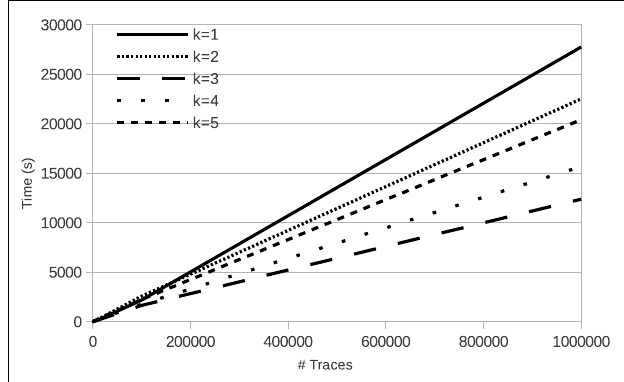
FIGURE 4 | LFkT run time varying the input size (number of traces)